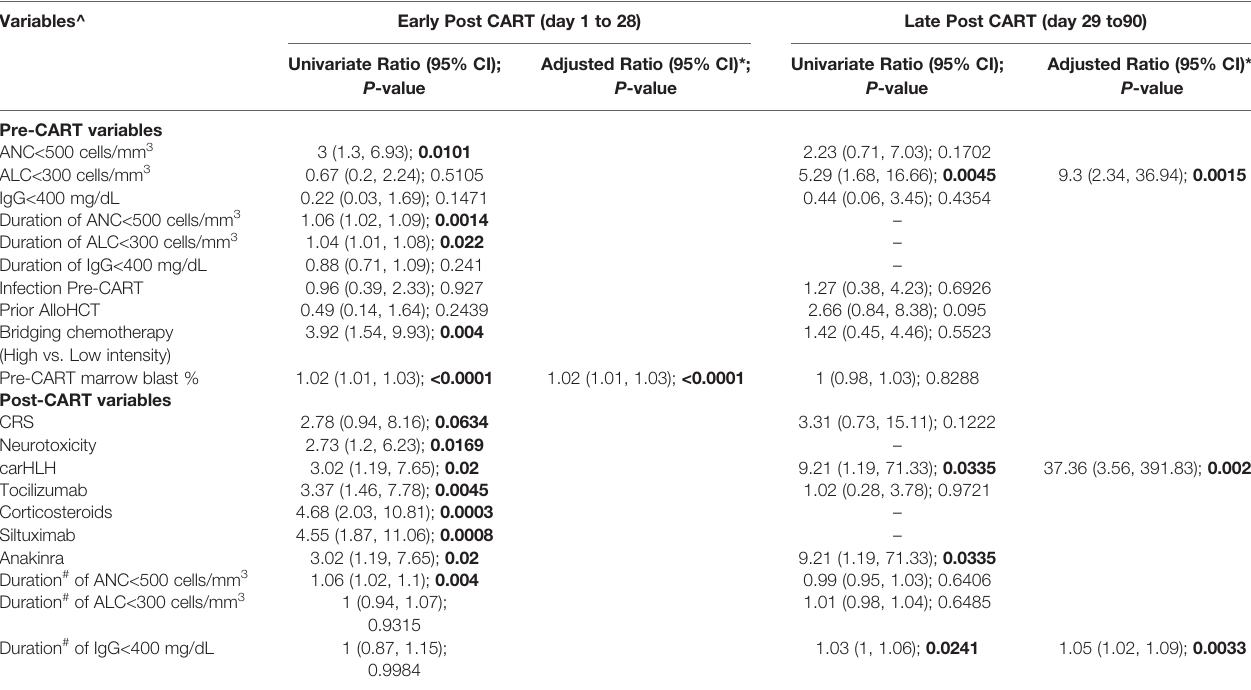
TABLE 4 | Association of pre- and post-CAR T cell therapy variables with post CAR T cell therapy infection density.